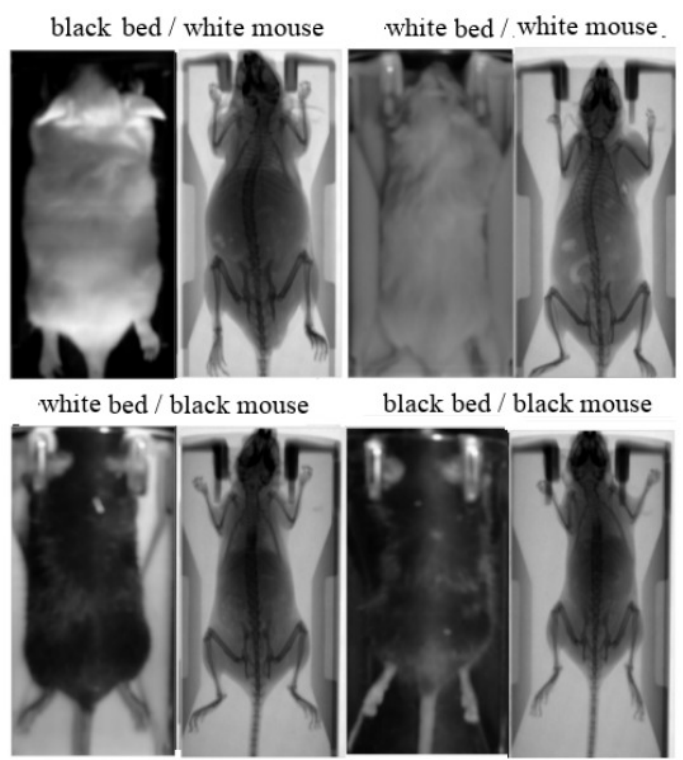
Figure 2. Aligned image pairs used for training. Photographic input image ( left ); Corresponding X-ray scan used as ground truth ( right